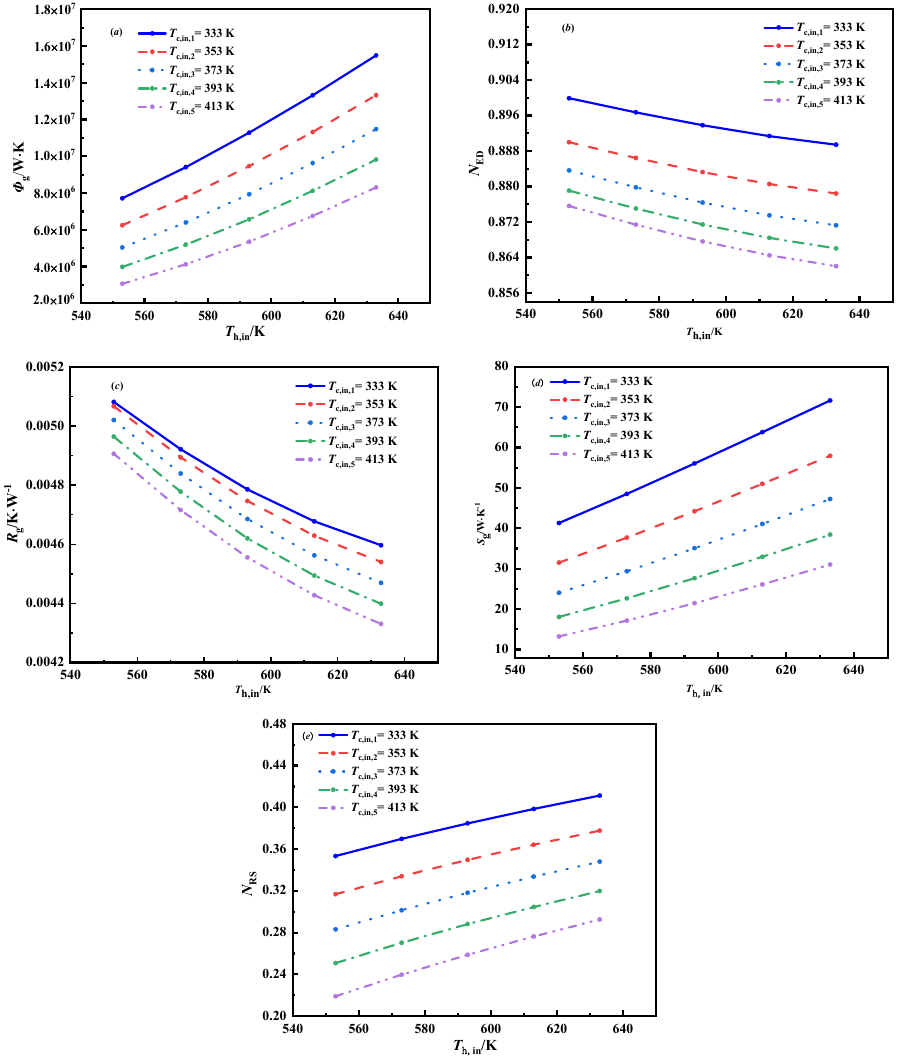
Figure 4. The 𝜙 ( a ), 𝑁 ED ( b ), 𝑅 g ( c ), 𝑆 g ( d ), and 𝑁 (cid:2902)(cid:2903) ( e ) versus the inlet temperature of sCO g